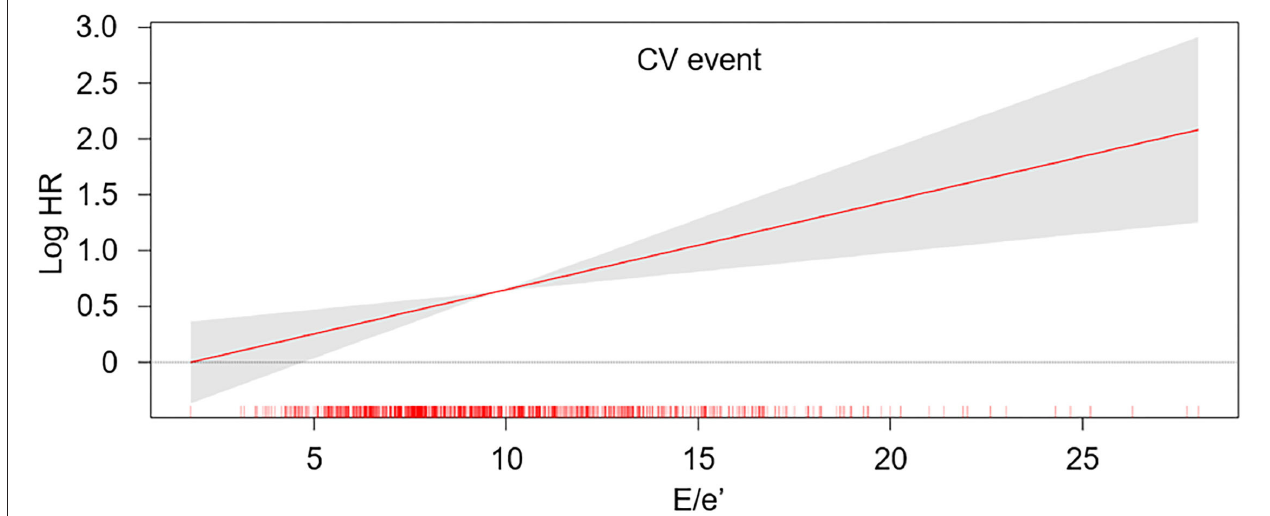
FIGURE 3 | Restricted cubic spline of E / e ′ on the risk of CV event. The adjusted HR of E / e ′ as a continuous variable for the risk of composite CV event is depicted. The model was adjusted for age, sex, Charlson comorbidity index, smoking history, medication [angiotensin-converting enzyme inhibitor/angiotensin II receptor blockers (ACEi/ARBs), diuretics, number of antihypertensive drugs, statins], body mass index (BMI), systolic blood pressure (SBP), diastolic blood pressure (DBP), hemoglobin, albumin, fasting serum glucose, high-density lipoprotein cholesterol (HDL-C), triglyceride (TG), 25-hydroxyvitamin D (25(OH) vitamin D), high-sensitivity C-reactive protein (hs-CRP), glomerular filtration rate (GFR), spot urine albumin-to-creatinine ratio (ACR), ejection fraction (EF) at the baseline. E / e ′ , ratio of the early transmitral blood flow velocity to early diastolic velocity of the mitral annulus; HR, hazard